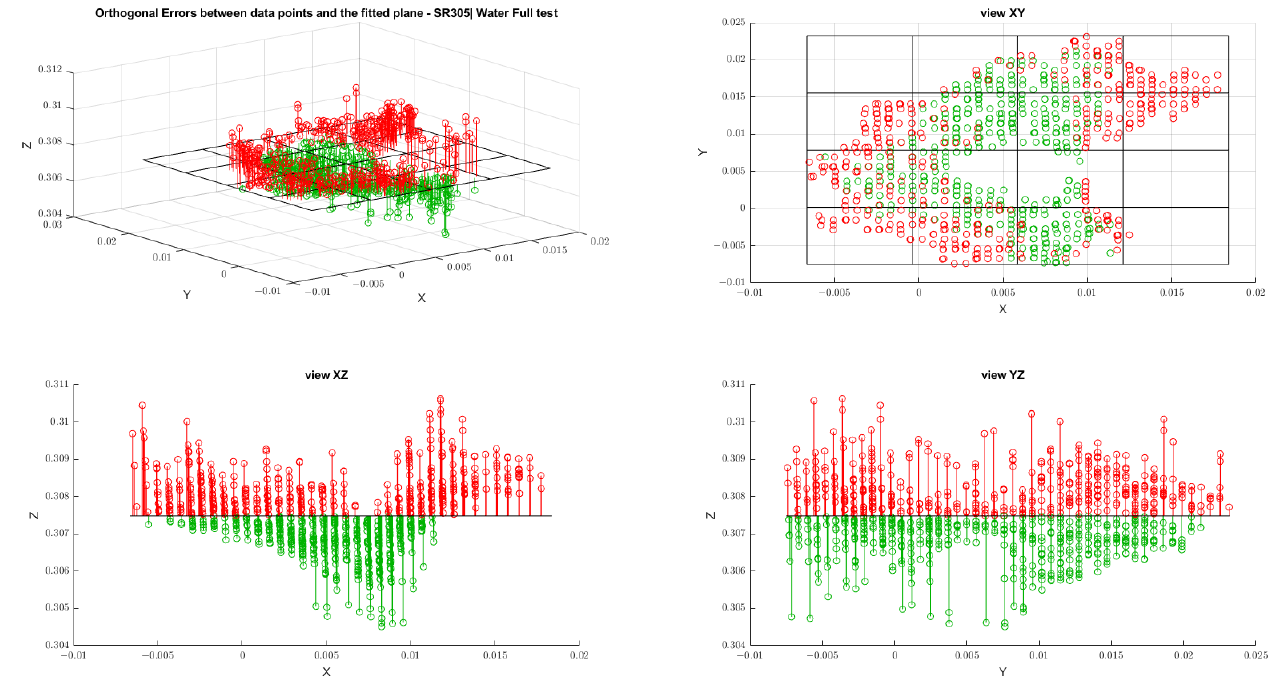
Figure A17. Results of orthogonal errors for the SR305 camera referring to the water full test.